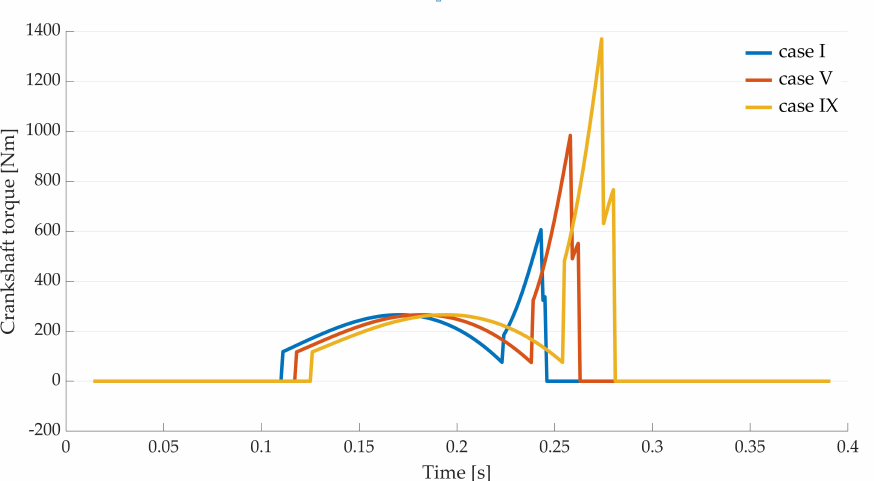
Figure 17. Torque values for the effective soil tillage process in the cases I, V, and IX (first cycle